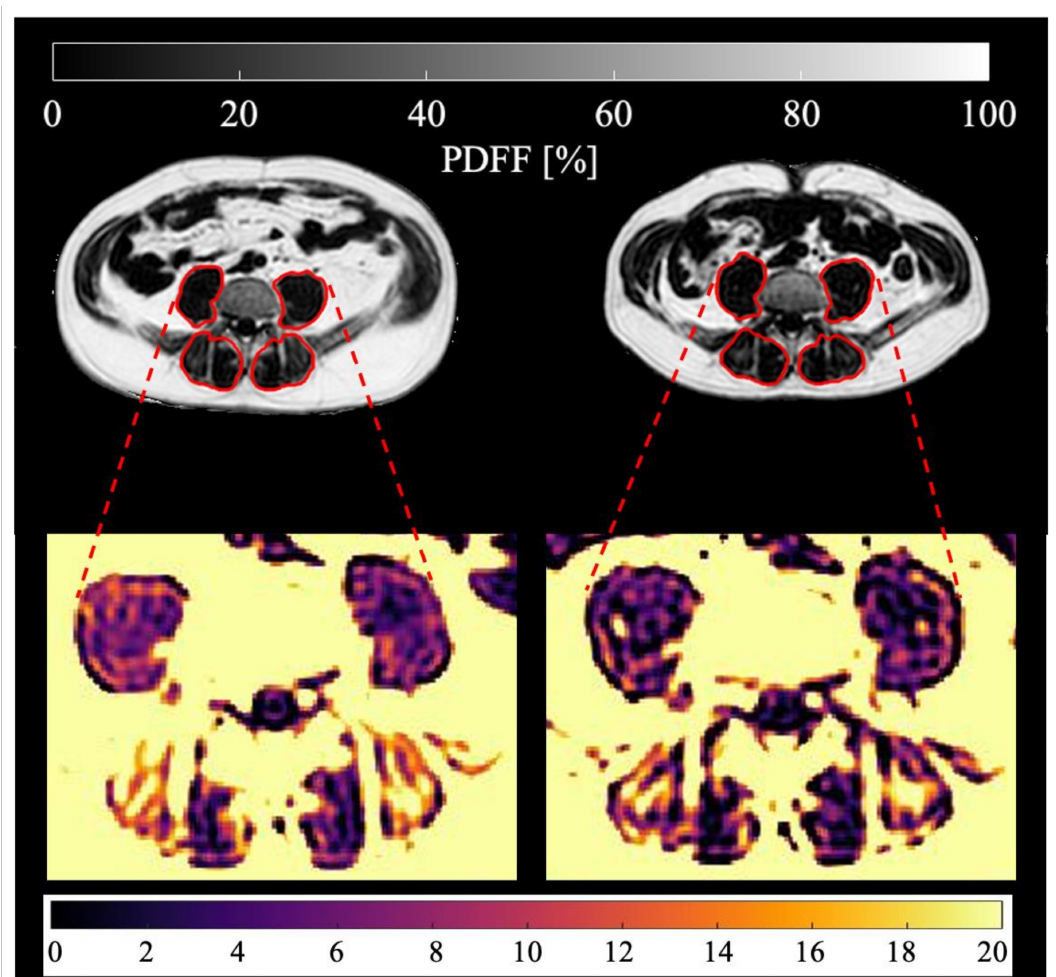
Figure 2. Representative PDFF maps of the psoas and erector spinae muscles (marked in red) of the same patient (male, 56 years old, BMI at baseline 28.6 kg/m 2 , BMI at follow-up 24.2 kg/m 2 , suffering from adenocarcinoma of the esophagogas- tric junction) are shown. Baseline scan is on the left, third follow-up scan after 218 days on the right. Mean psoas PDFF at baseline: 12.02%, mean erector spinae PDFF at baseline: 16.69%, mean psoas PDFF at follow-up: 8.62%, mean erector spinae PDFF at follow-up: 14.85%.